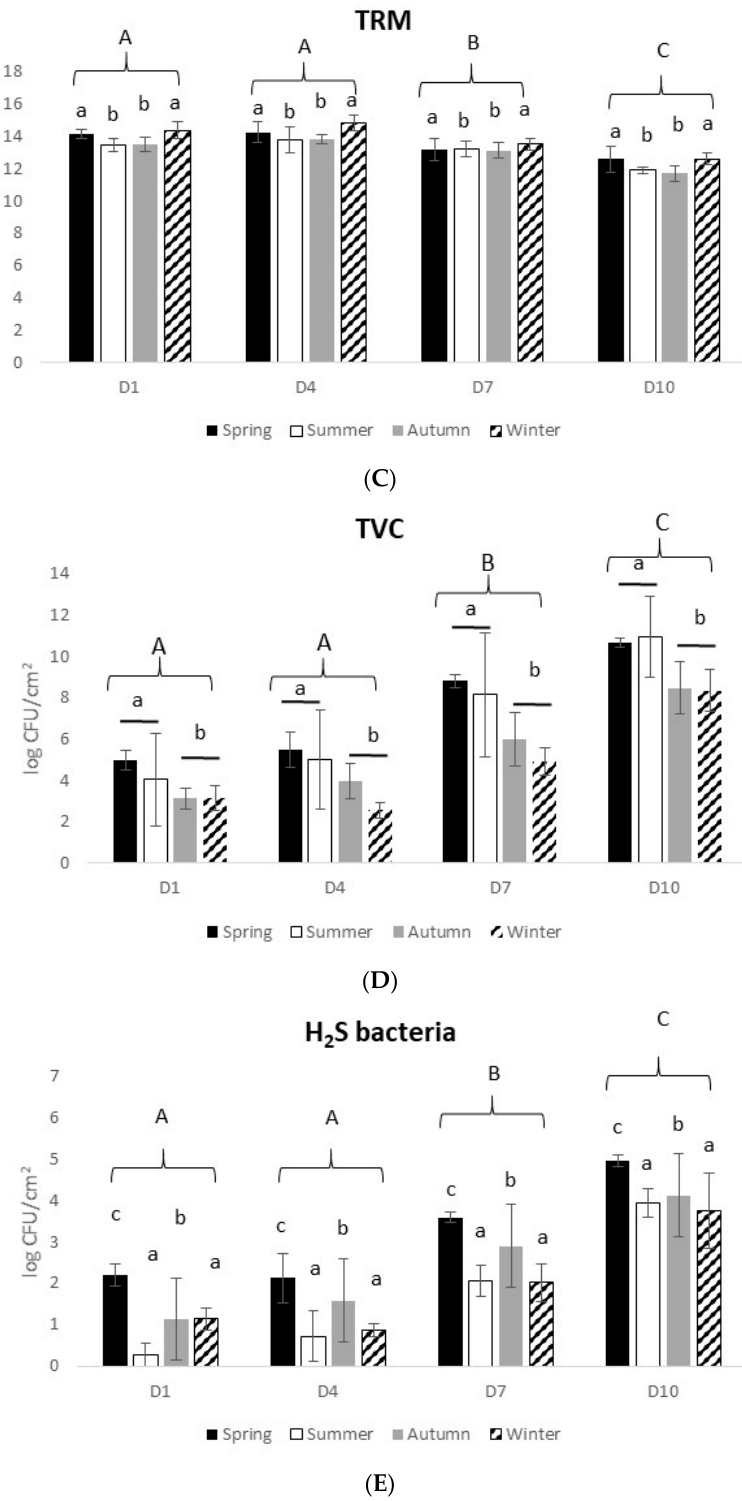
Figure 2. Seasonal seabass freshness profile over 10 days on ice, assessed by different methods: ( A ) Quality Index Method, ( B ) EC scheme, ( C ) Torrymeter (TRM), ( D ) microbiology (TVC), and ( E ) microbiology (H 2 S-producing bacteria). Values represent mean ± SD ( n = 6). In Figure 2C–E, different uppercase letters indicate significant differences among days, while different lowercase letters indicate significant differences among seasons. In the other figures, different letters indicate significant differences among